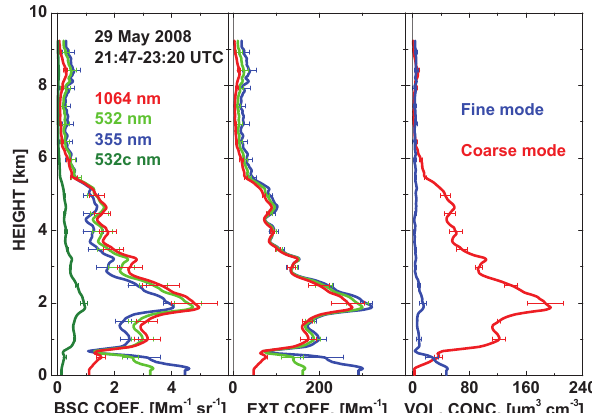
Fig. 2. Range-corrected signal at 1064nm measured on Fig. 2. Range–corrected signal at 1064 nm measured on 29 May 29 May 2008, 21:47–23:15UTC (signal counts in logarithmic 2008, 2147–2315 UTC (signal counts in logarithmic scale). The scale). The vertical resolution of the lidar measurement is 60m; the vertical resolution of the lidar measurement is 60 m, the temporal temporal resolution is 30s. The 500nm AOT was 0.7–0.75 up to resolution is 30 s. The 500 nm AOT was 0.7–0.75 up to 6 km height 6km height in the evening of 29 May. in the evening of 29 May.